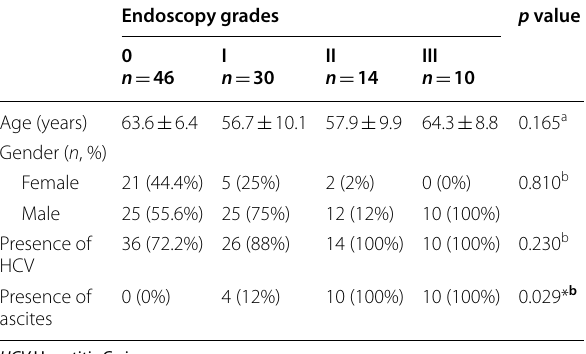
Table 8 Regression model of MDCT and clinical findings for predicting the EV ( N 100) =